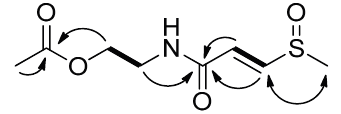
Figure 3. COSY (bold lines), key HMBC (arrows), and NOESY (left right arrow) correlations of 2